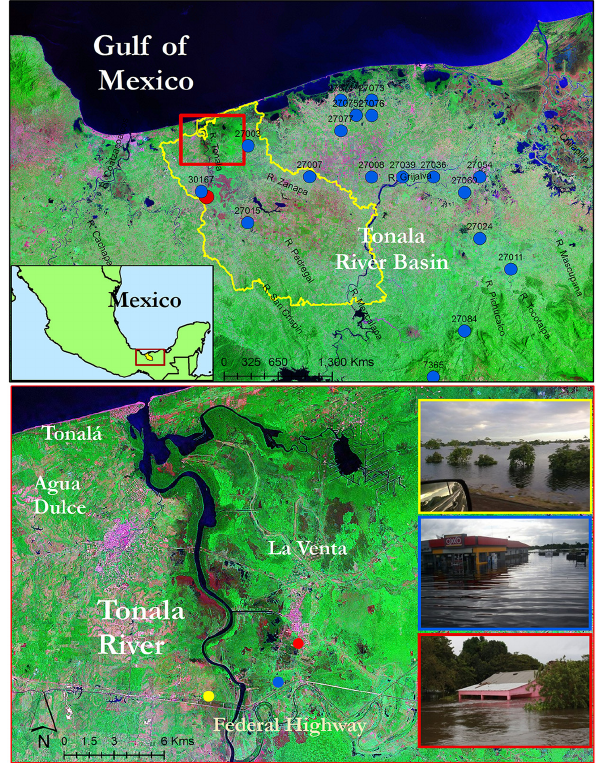
Figure 1. Top panel: location of the Tonalá River basin in Mexico; the yellow line represents the boundary limits of the catchment; blue dots: locations of weather stations; red dot: streamflow gauge. Bot- tom panel: close up of the study area and photographs of observed impacts; yellow, blue and red dots represent the locations at which the photos were